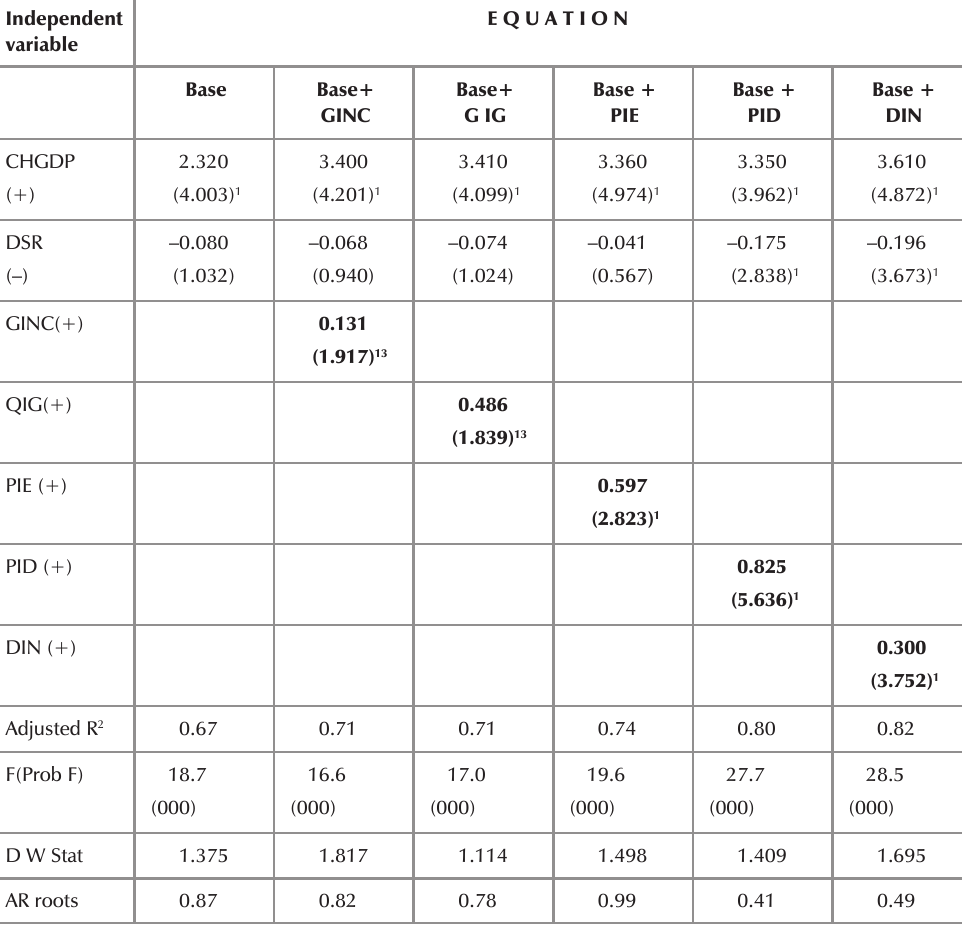
Nigeria: Regression of real gross domestic investment on the level of democratisation. Dependent variable = lnGDI [N=